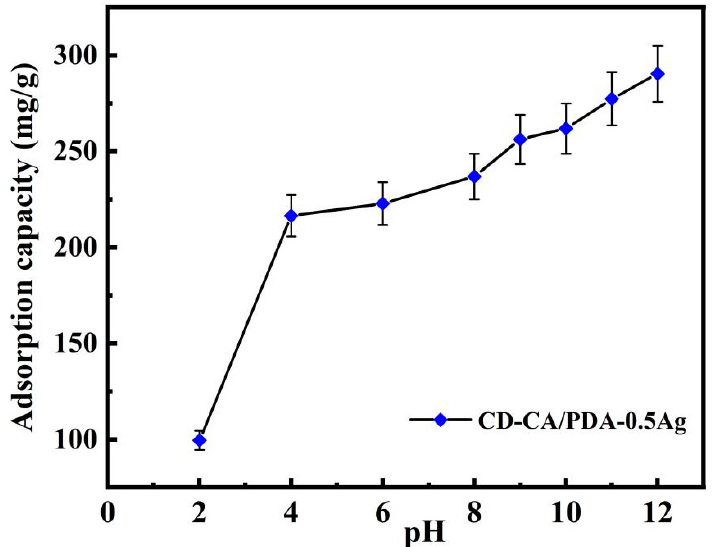
Figure 6. Effect of initial pH on adsorption capacity of CD-CA/PDA-0.5Ag. ([MB] 0 = 300 mg/L, [adsorbent] = 1 g/L, contract time = 12 h, T = 25 °C).